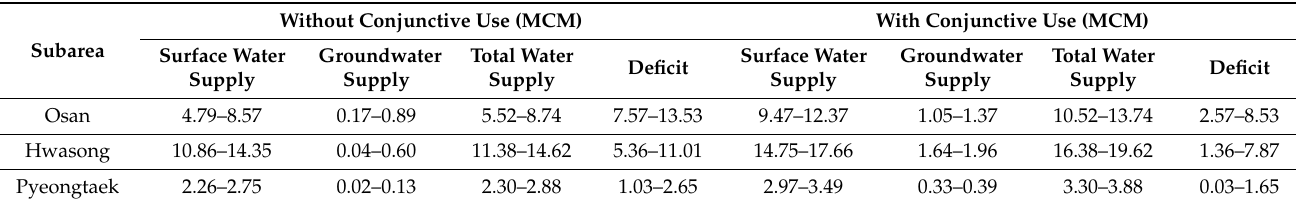
Table 3. Distribution of surface water, groundwater, total supply, and deficit with/without conjunctive use in the Osan watershed.